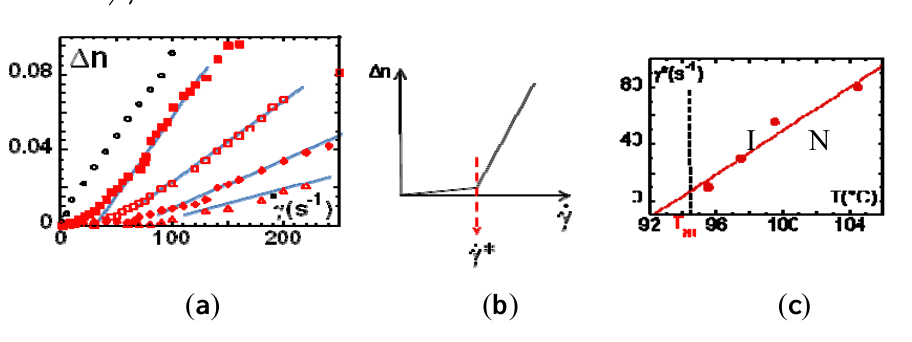
. Sample: PANO2 at 0.060 mm ( ● ) gap